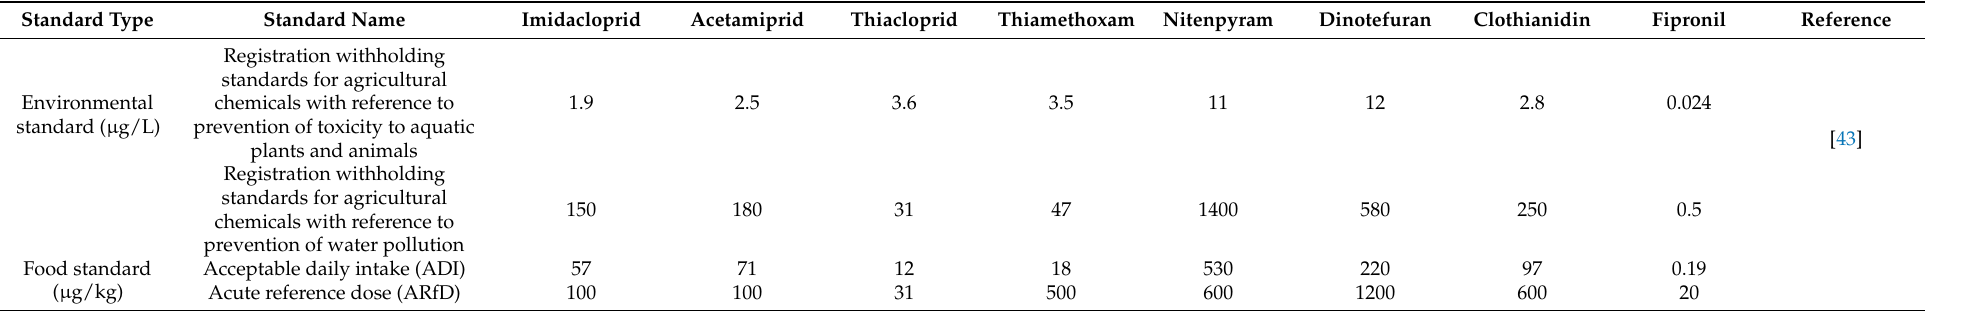
Table 2. Environmental standards and food standards for various neonicotinoid pesticides in Japan (as of 29 June